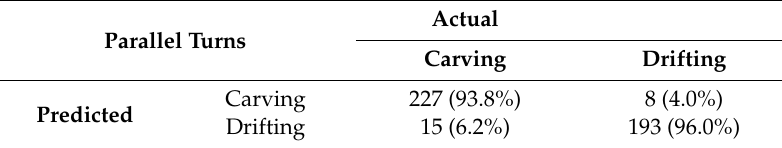
Table 7. Confusion matrix for parallel turns—Random forest.